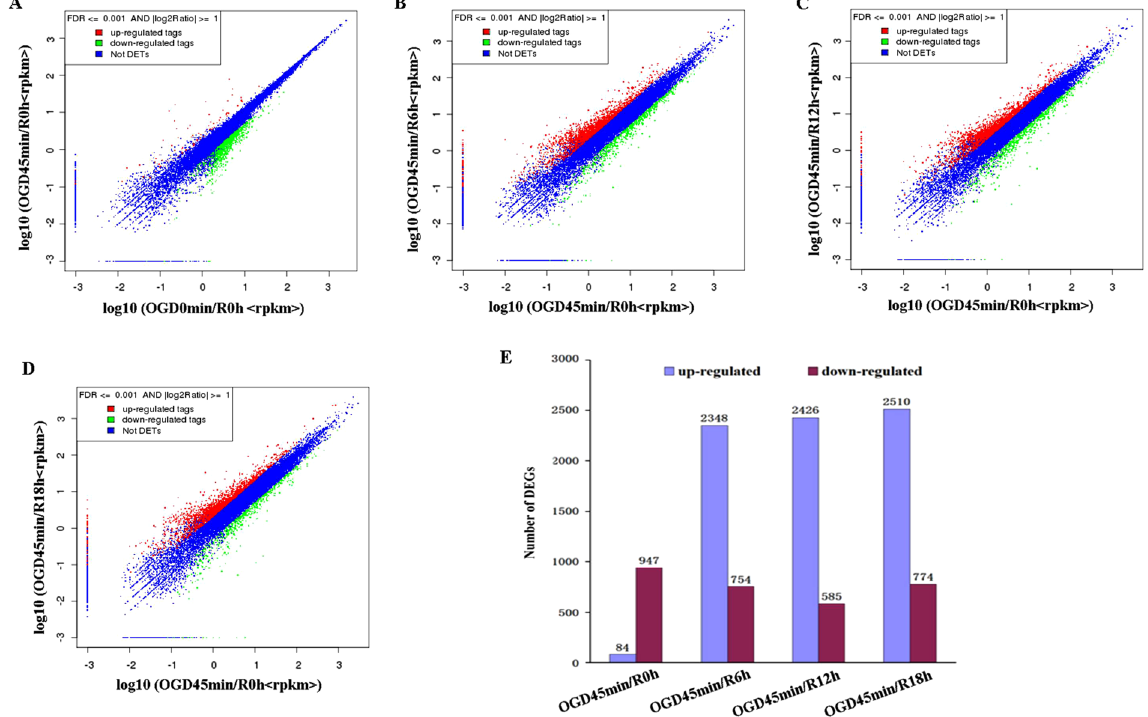
Figure 1. Comparisons of gene expression profiles of primarily cultured hippocampal neurons upon oxygen glucose deprivation (OGD), and OGD with reperfusion. ( A–D ) The overview of gene expression profiles of OGD 45 min/R 0 h vs OGD 0 min/R 0 h ( A ); OGD 45 min/R 6 h vs OGD 45 min/R 0 h ( B ); OGD 45 min/R 12 h vs OGD 45 min/R 0 h ( C ); OGD 45 min/R 18 h vs OGD 45 min/R 0 h ( D ). ( E ) Bar graph demonstrating the quantity of positively and negatively expressed transcripts upon OGD and OGD with reperfusion (FDR ≤ 0.001 and a fold change >